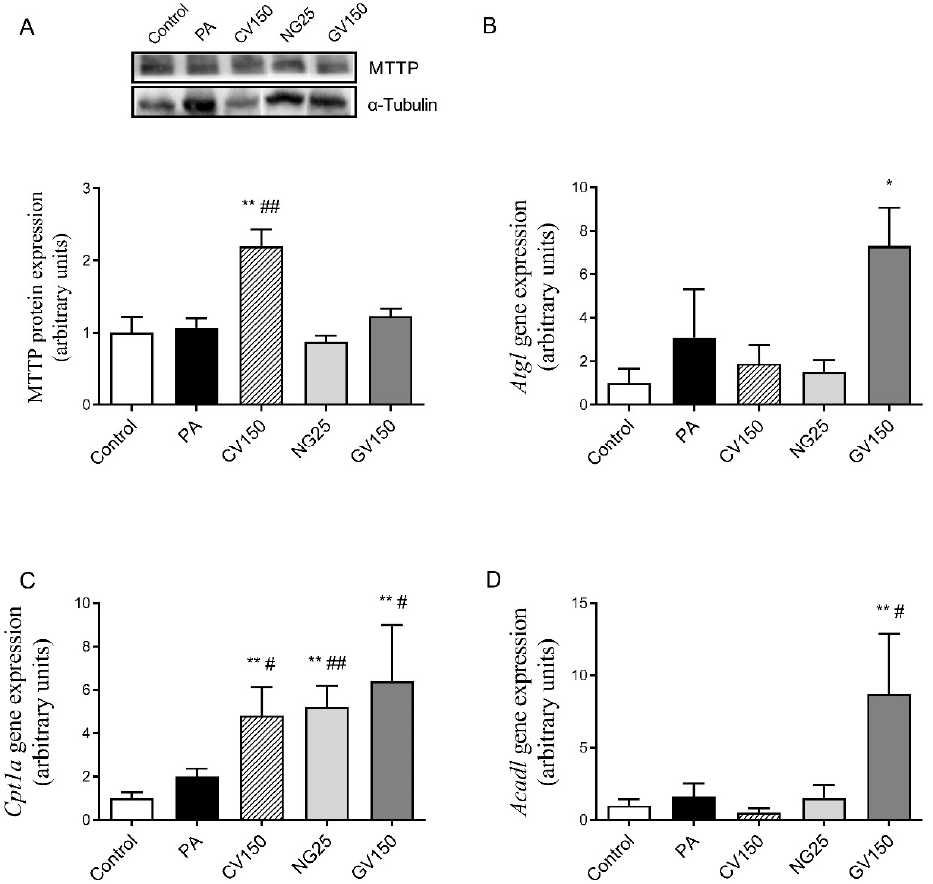
Figure 6. Protein expression of MTTP ( A ) and gene expression of Atgl ( B ), Cpt1a ( C ) and Acadl ( D ) in AML12 hepatocytes exposed or not to 0.3 mM of palmitic acid (PA) with or without Chlorella vulgaris (CV) at 150 µ g/mL, Nannochloropsis gaditana (NG) at 25 µ g/mL and Gracilaria vermiculophylla (GV) at 150 µ g/mL for 18 h. Data are means ± SEM (standard error of the mean). * p < 0.05, ** p < 0.01 vs. control cells. # p < 0.05 and ## p < 0.01 vs. PA cells. Acadl : long chain acyl-CoA dehydrogenase; Atgl : adipose triglyceride lipase; Cpt1a : carnitine palmitoyltransferase 1a; MTTP: microsomal triglyceride transfer protein.